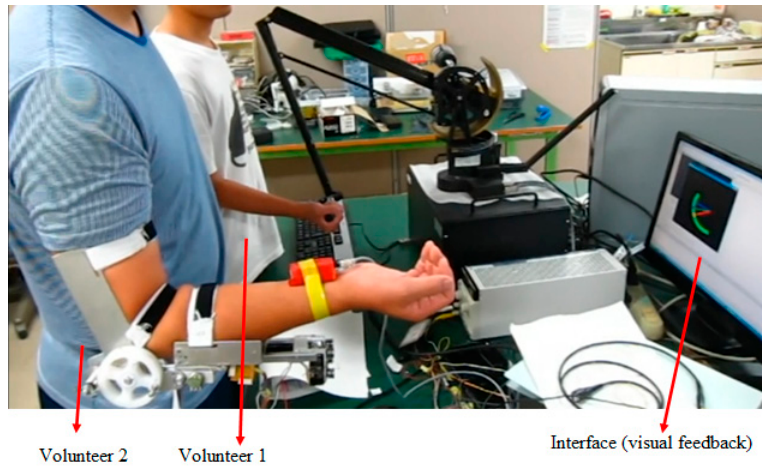
Figure 10. Therapist-in-the-loop training via visually shared model.